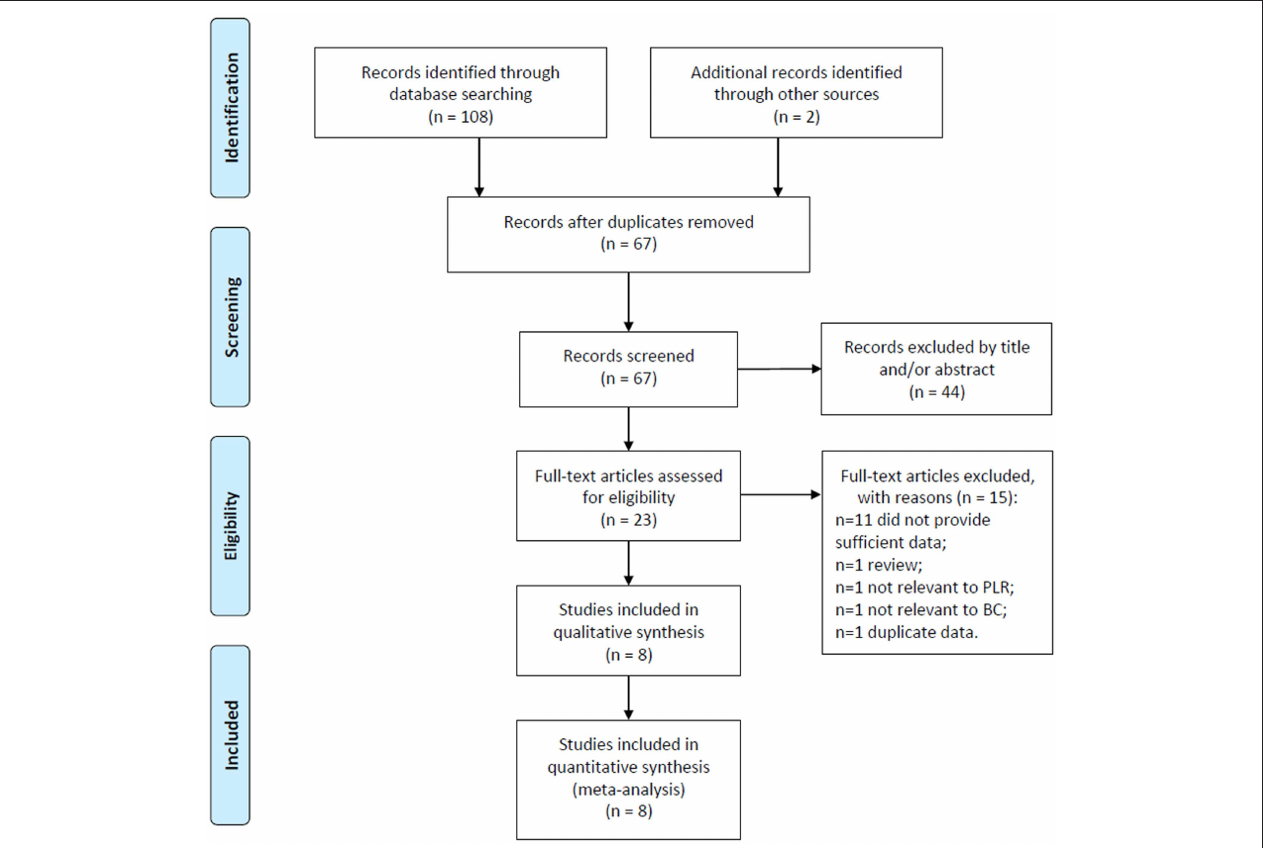
FIGURE 1 | Flow chart of the included studies.